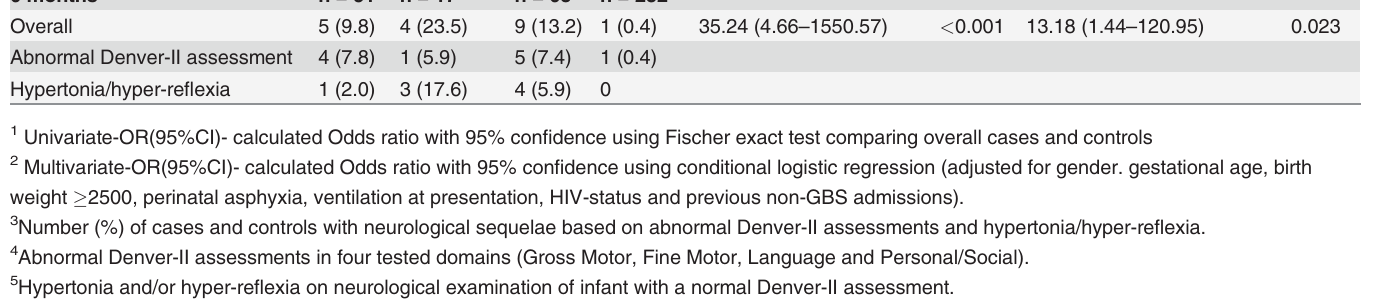
Multivariate-OR(95%CI)- calculated Odds ratio with 95% con fi dence using conditional logistic regression (adjusted for gender. gestational age, birth weight (cid:1) 2500, perinatal asphyxia, ventilation at presentation, HIV-status and previous non-GBS admissions). 3 Number (%) of cases and controls with neurological sequelae based on abnormal Denver-II assessments and hypertonia/hyper-re fl exia. 4 Abnormal Denver-II assessments in four tested domains (Gross Motor, Fine Motor, Language and Personal/Social). 5 Hypertonia and/or hyper-re fl exia on neurological examination of infant with a normal Denver-II assessment.